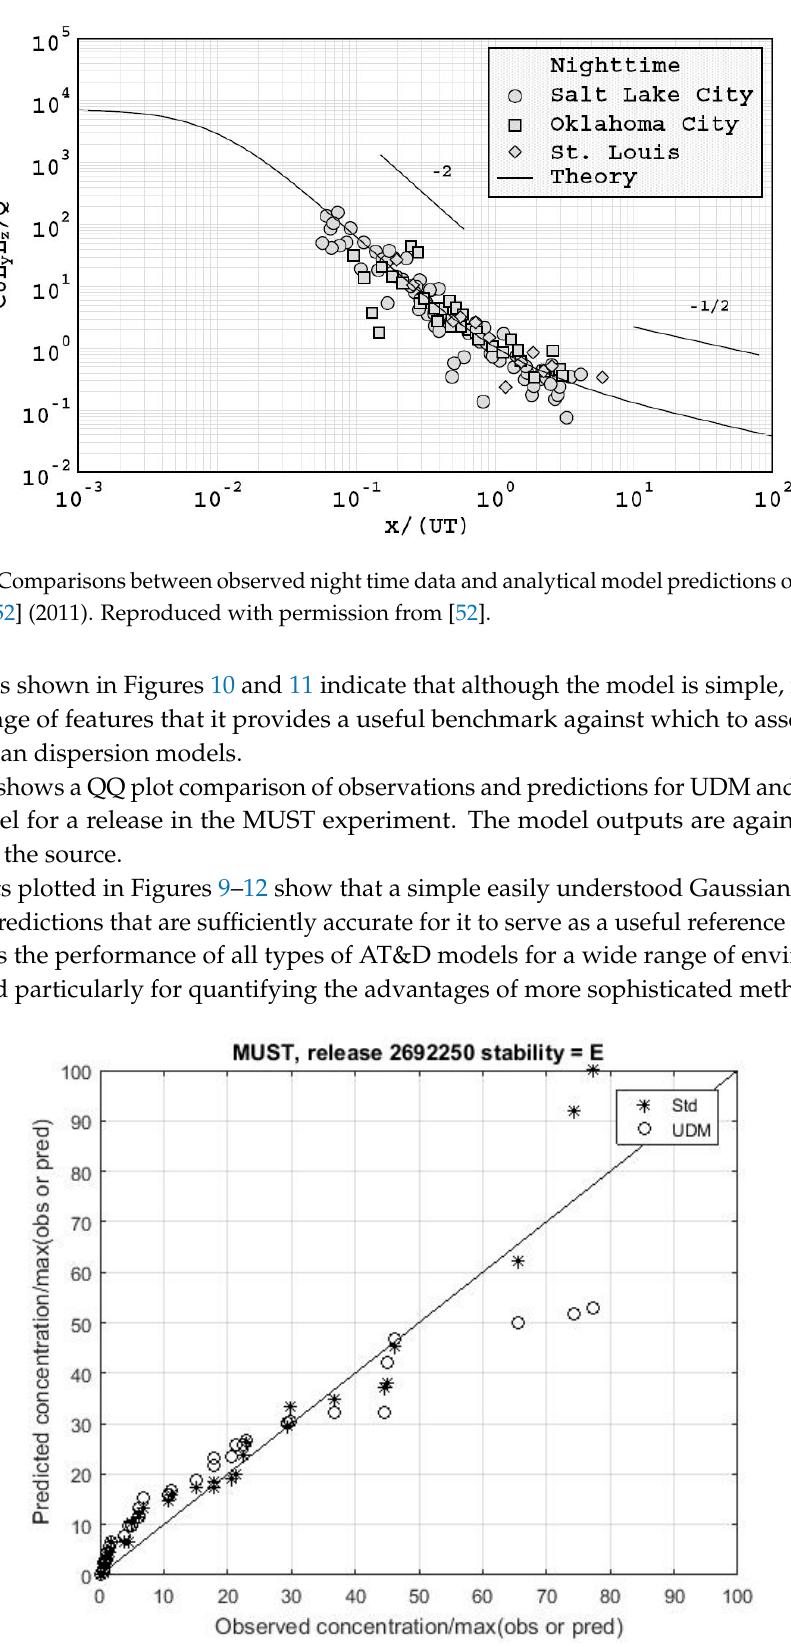
Figure 12. Comparisons between UDM predictions and observations for MUST release 2692250.